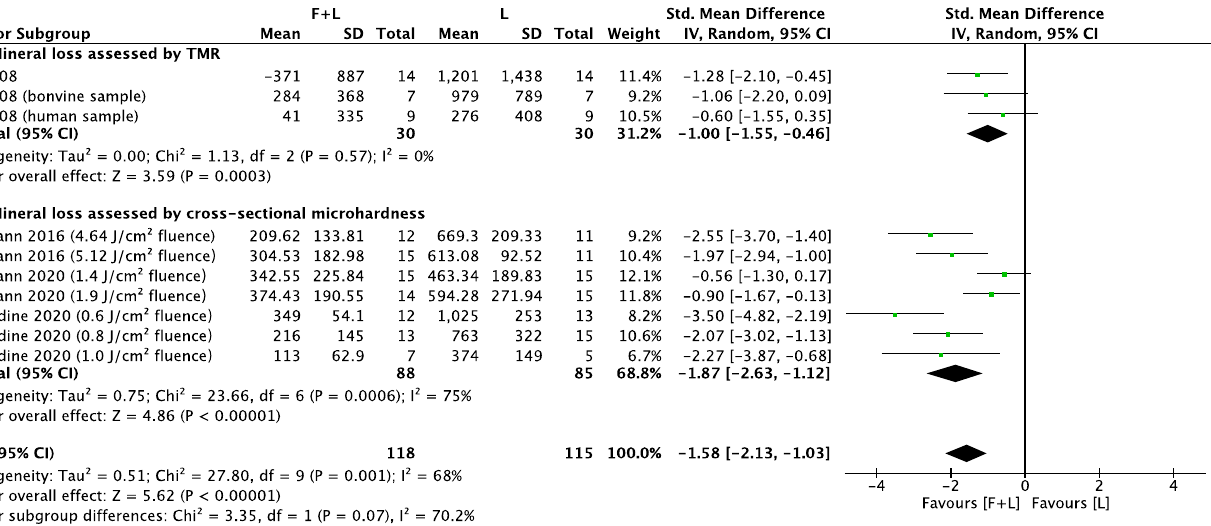
Figure 3. Meta ‐ analysis comparing the effect of the treatment combining fluoride and laser (F + L) and treatment using only fluoride (L) on mineral loss.